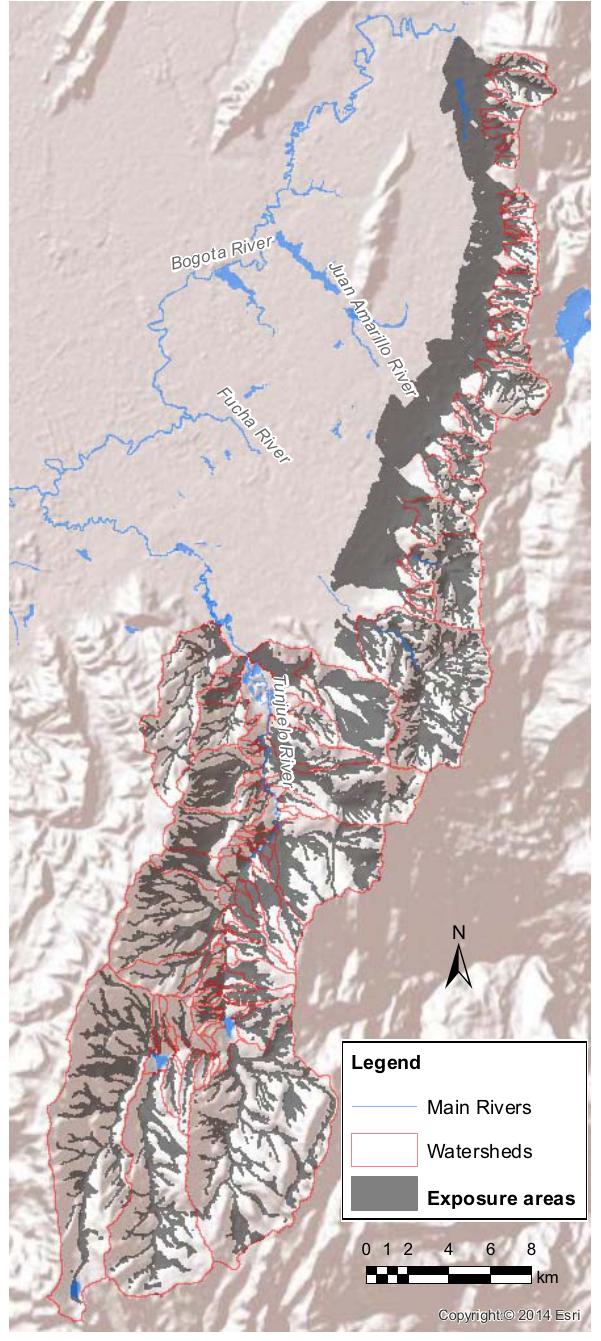
Figure 4. Exposure areas.